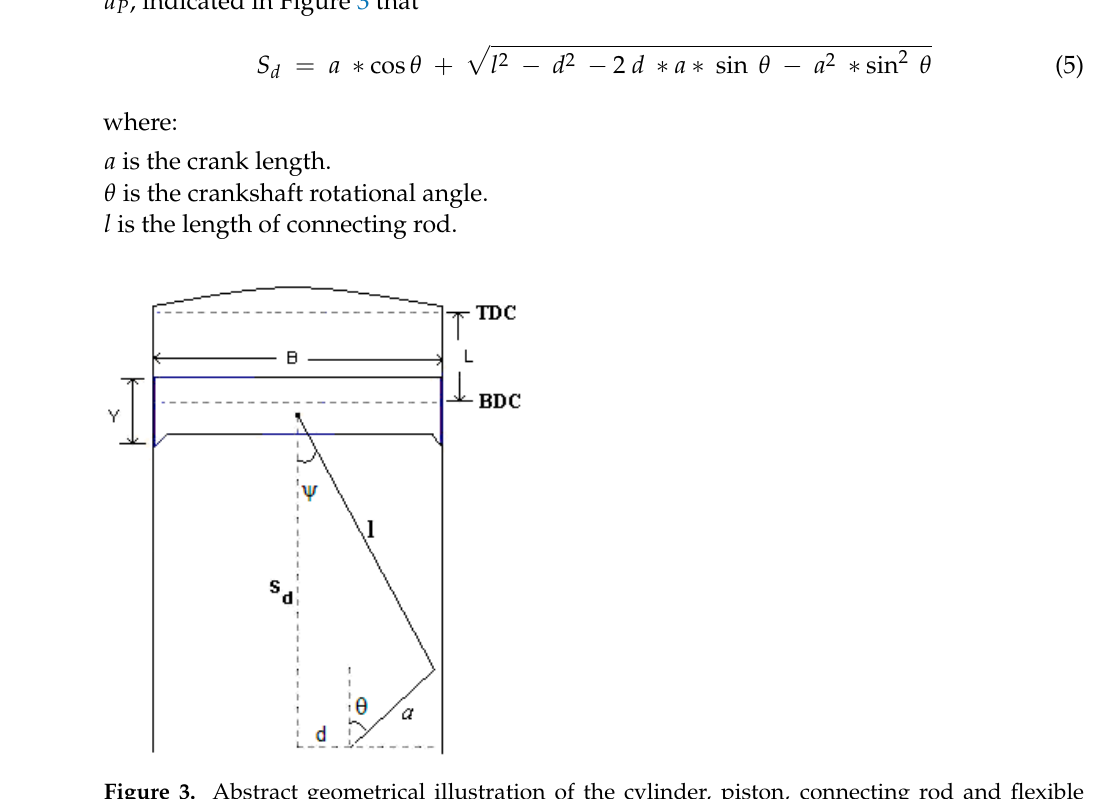
Figure 3. Abstract geometrical illustration of the cylinder, piston, connecting rod and flexible crankshaft.